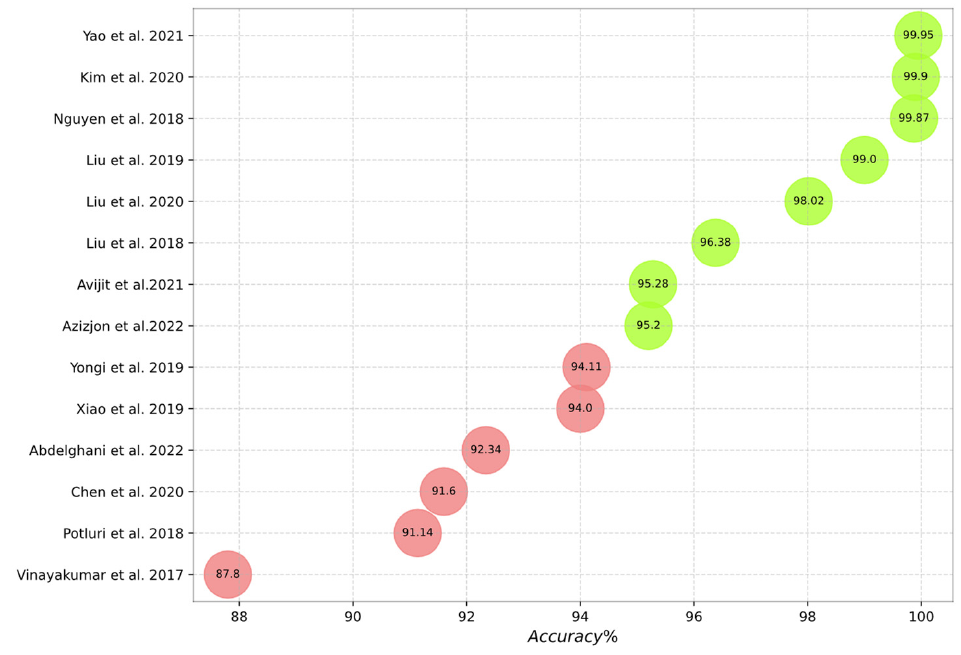
Figure 11. Accuracy of the studied schemes on the KDD Cup99 dataset [16,17,19,23,26,39,40,62,65,69, Figure 11.